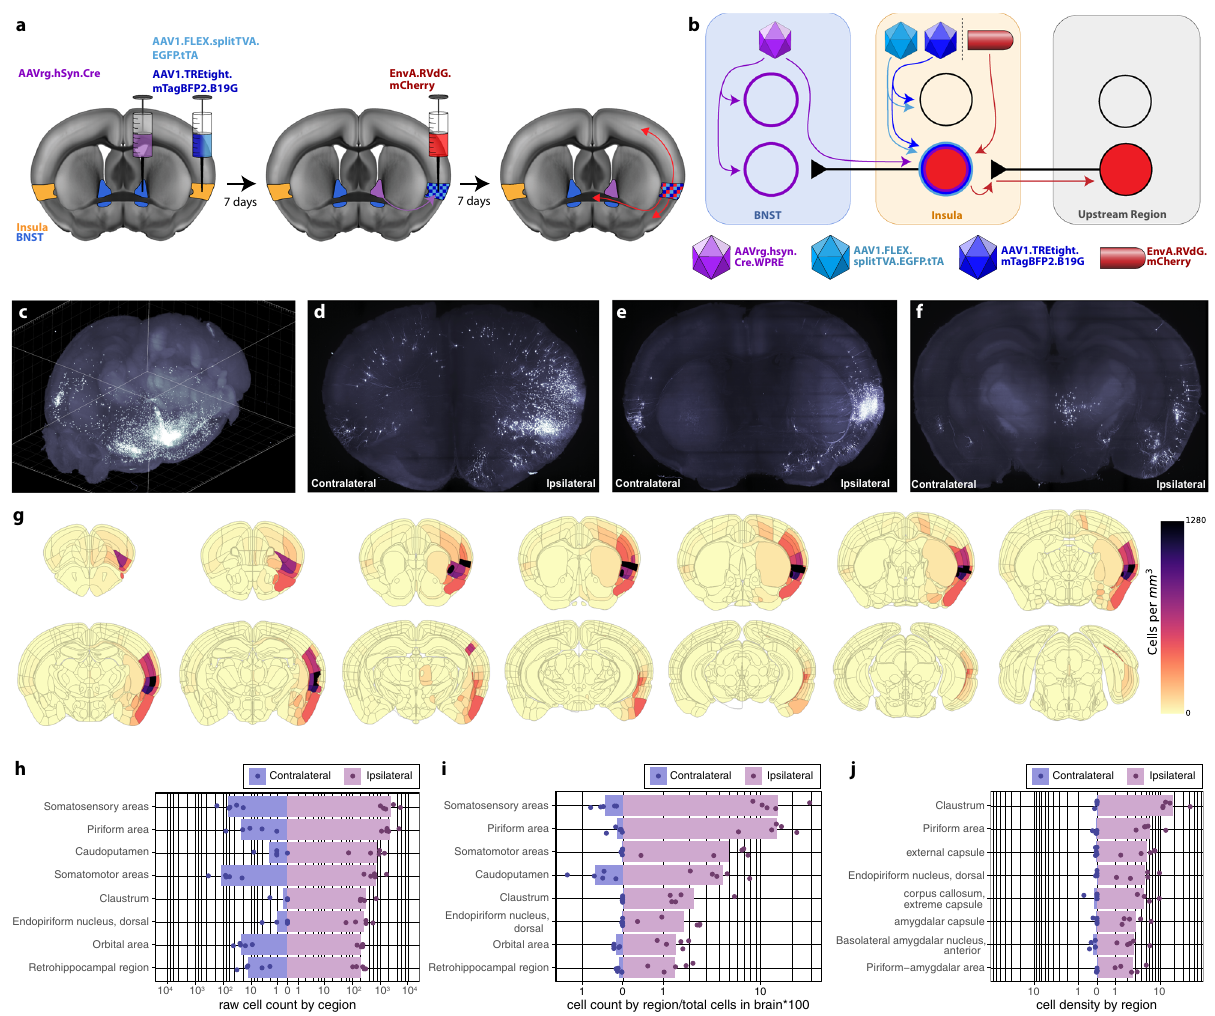
Fig. 6 The control network for the insula → BNST pathway includes piriform, somatosensory, somatomotor, and amygdalar nuclei. a Diagram of the viral strategy for tracing the control network for insula → BNST cells. AAVrg.Cre (purple) was injected into the BNST. Viruses carrying the Cre-dependent helper proteins TVA (cyan) and B19G (blue) were injected into the insula. After seven days, rabies virus (EnvA.RVdG.mCherry; red) was injected into the same region of the insula. Seven days later, the brains were collected and started on the light sheet microscopy pipeline. b Schematic of rabies tracing strategy. AAVrg.Cre infects cells locally in the BNST and afferents. The TVA and B19G viruses infect many neurons near the injection site, but only express their proteins in insula → BNST neurons that also express Cre. Entry of the modi fi ed rabies is restricted to TVA-expressing cells, and transsynaptic retrograde infection is limited to cells expressing B19G. Therefore, labeled neurons outside of the injection region are monosynaptically connected to the insula → BNST neurons. c Maximum projection image of 3D reconstruction of light sheet data set to illustrate insula → BNST control network. Olfactory bulbs are in the bottom left corner, and the cerebellum is in the top right corner. d Resampled images in the coronal plane at the level of the anterior insula. e At the level of the BNST, and f at the level of thalamic and amygdalar structures. g Distribution of labeled neurons represented as a composite whole-brain density heatmap (averaged from fi ve mice) of semiautonomously quanti fi ed insula → BNST control network cells as density in mm 3 . h Graphical representation of cell densities in top eight regions (by raw cell count) labeled as part of the labeled insula → BNST control network of fi ve mice. Bars: mean from all three counts per region. Points: counts from individual animals. Ipsilateral counts are on the right in purple. Contralateral counts are on the left in blue. The x -axis is an inverse hyperbolic sine transformation. i Top eight regions (by cell count per region/total cells in each respective brain × 100) of the labeled insula → BNST control network. j Top eight regions (by cell density) of the labeled insula → BNST control struggle bout onset (Fig. 9d, e). Further, there was no correlation between bout length and AUC or maximum peak amplitude (Fig. 9f – m). Thus, motor → insula cells represent a distinct population of neurons recruited both prior to and during motor action.